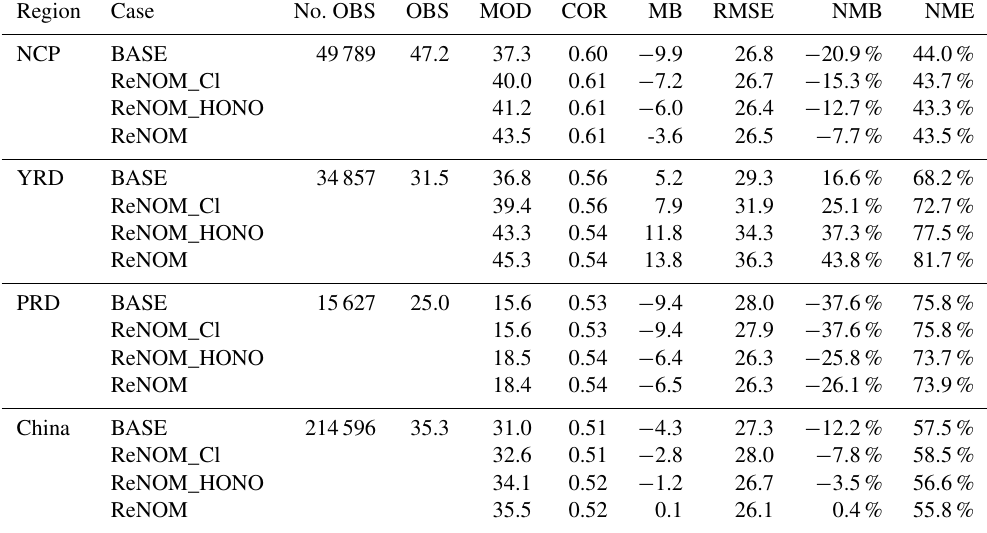
Table 5. Statistics of model performance in the base and ReNOM cases for hourly O 3 measurements (ppb) at ∼ 908MEP air quality monitoring stations during the simulation period (27 June–7 July 2014). Region Case No. OBS